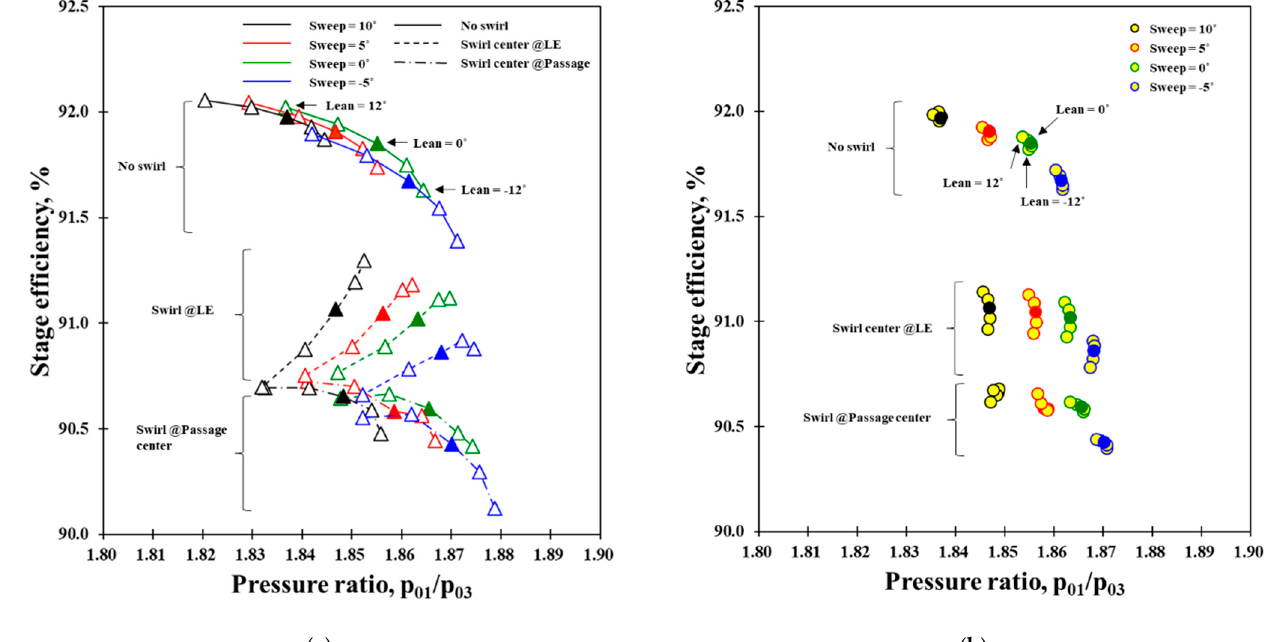
Figure 8. Comparison of stage efficiencies: ( a ) Straight lean; ( b ) Compound lean.